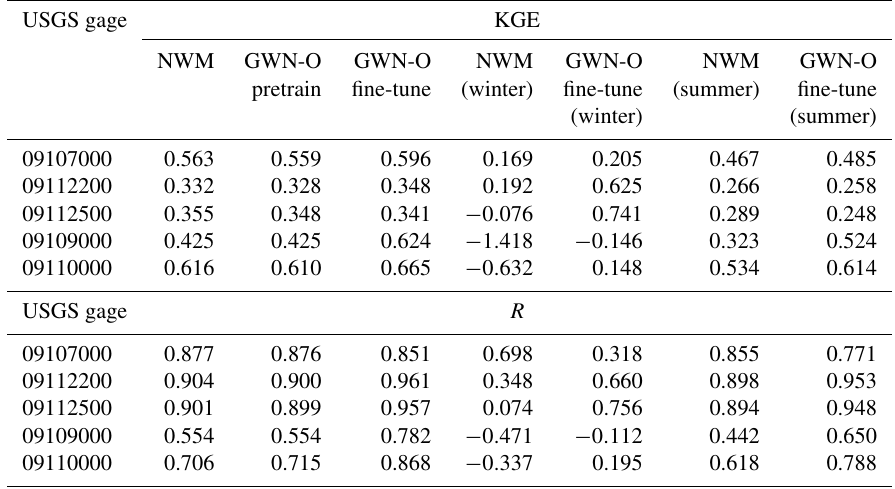
Table 2. Comparison of the KGE and R of the NWM, pretrained GWN-O, fine-tuned GWO-O against the USGS gage data. The last four columns show the values for winter and summer seasons.